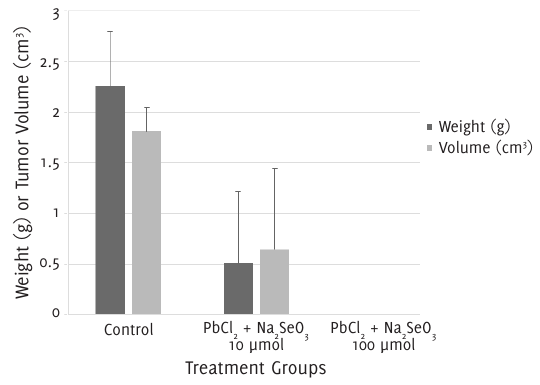
) and Sodium Selenite (Na 2